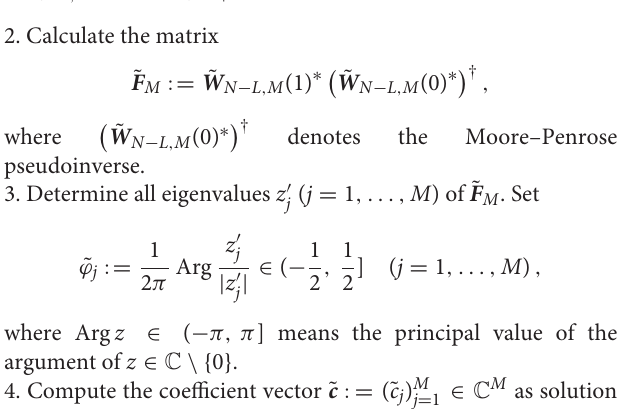
Algorithm 2.9 (ESPRIT) to the reconstruction of sparse